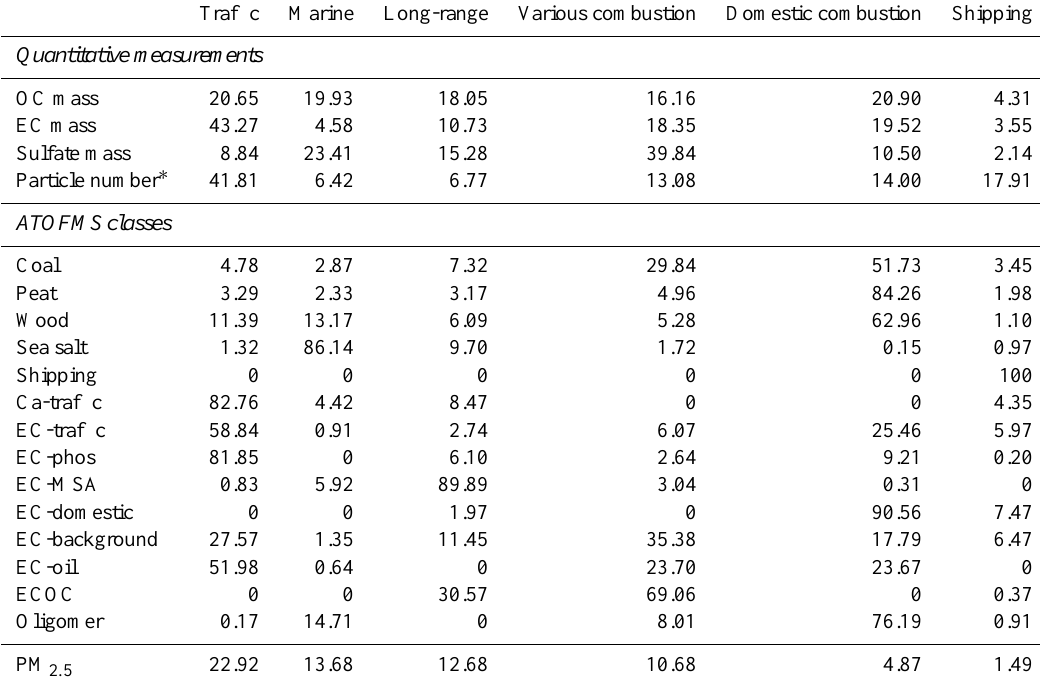
Table 2. Percentage variable contributions to the six factor PMF model and estimated percentage contribution of each factor to the measured ambient PM 2 . 5 mass. ∗ Mobility diameter range